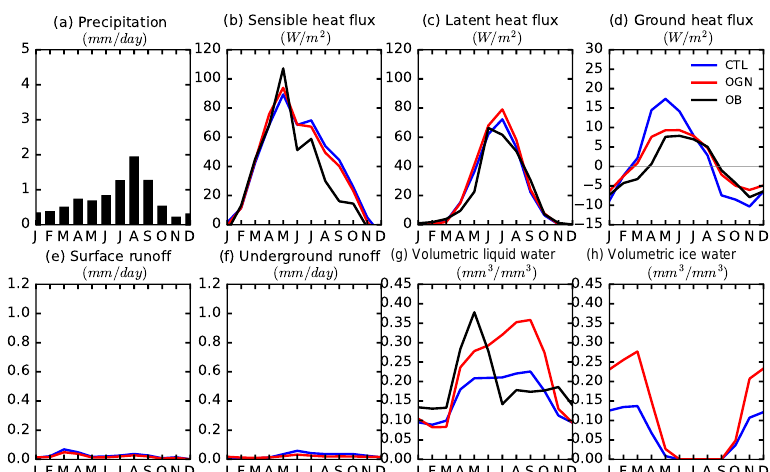
Figure 10. Annual cycle of selected surface energy and hydrologic cycle fields for drought years. The black line is the observation. Note that (a) is the observed precipitation, (b) is sensible heat flux, (c) is latent heat flux, (d) is ground heat flux, (e) is surface runoff, (f) is underground runoff, (g) is volumetric liquid water content for soil layer one, (h) is volumetric ice water content for soil layer one.